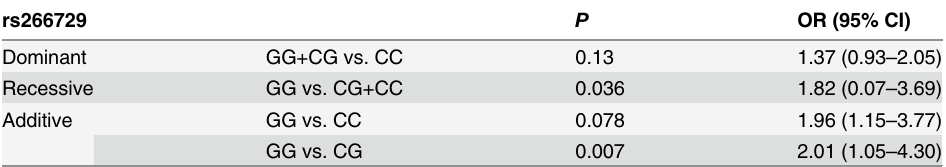
Table 6. Logistic regression analysis of